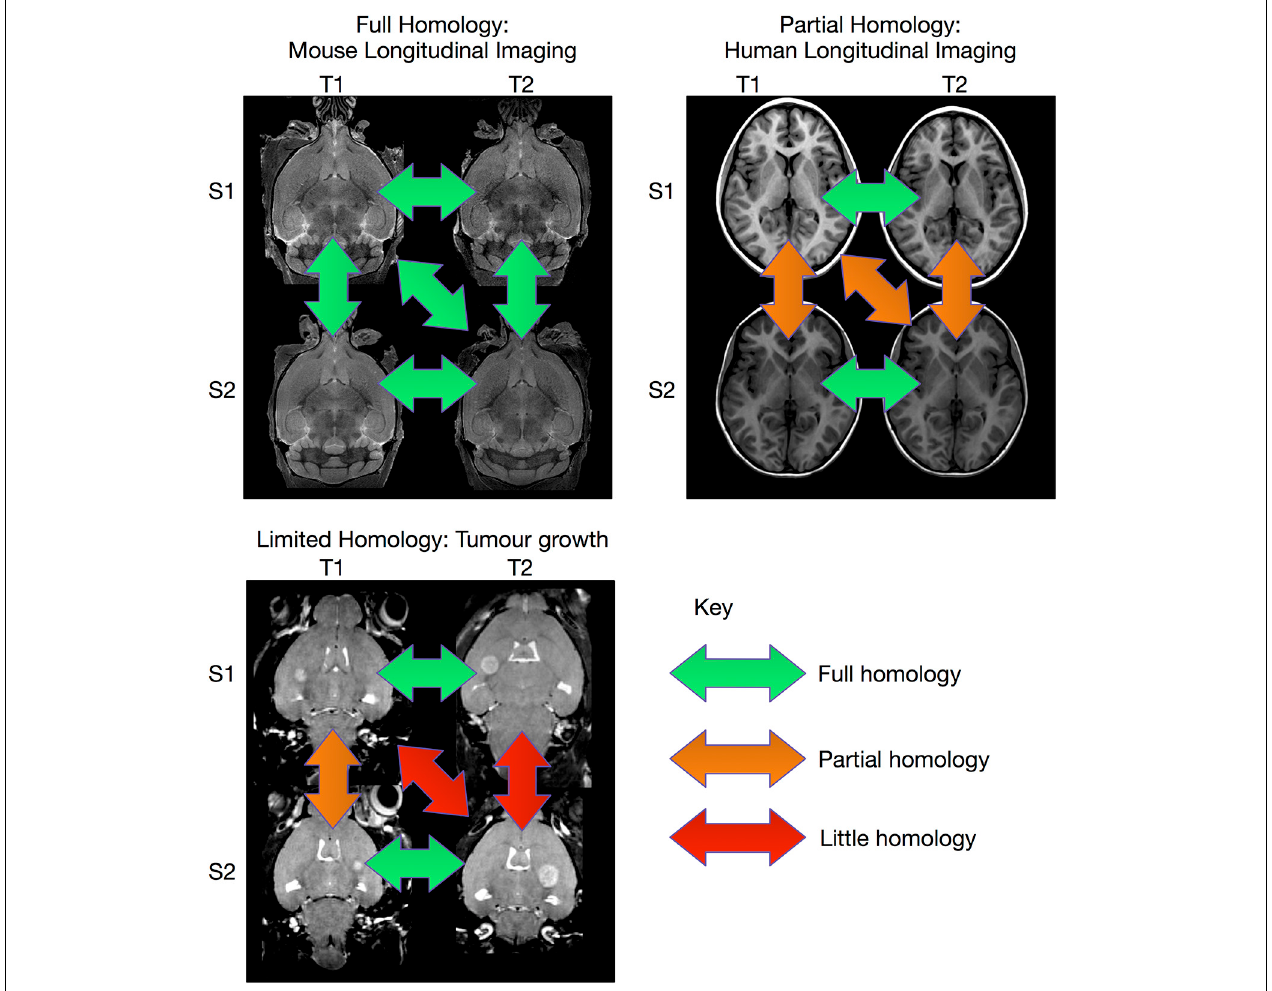
FIGURE 1 | Overview of registration scenarios. In the case of aligning cross-sectional adult mouse brains full homology exists between any pair of brains. Human longitudinal data, on the other hand, has full homology between scans of the same subject but more limited homology between different subjects. In the case of